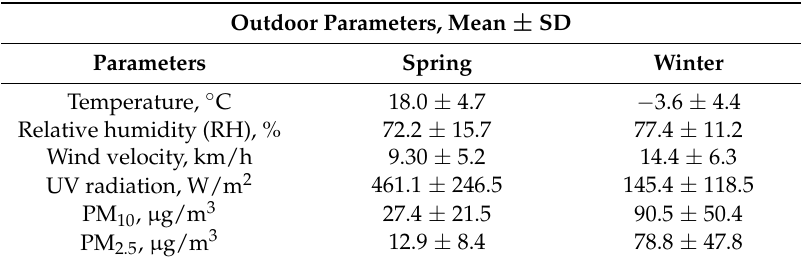
Table 1. Environmental parameters during sample